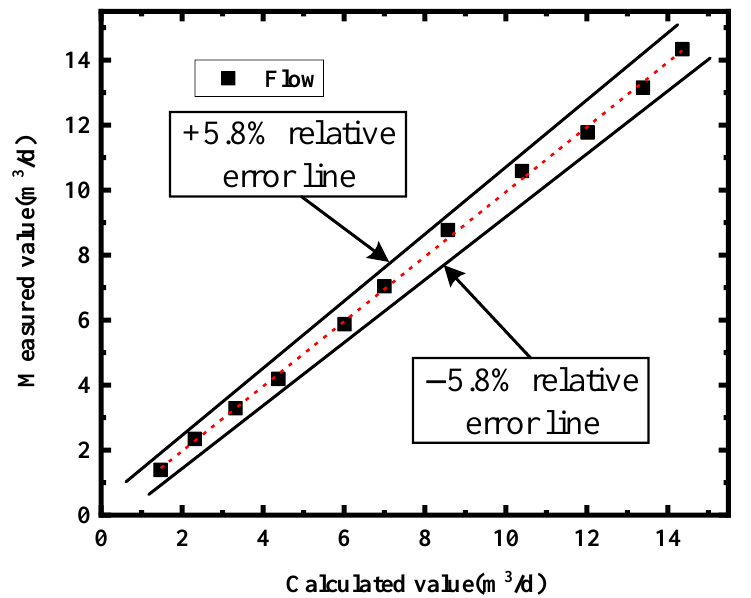
Figure 11. Error chart of measured value and calculated value.